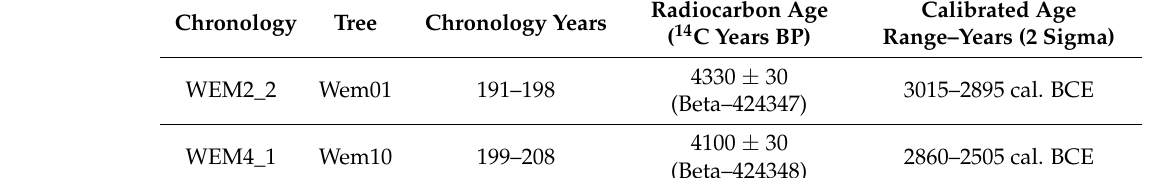
Table 3. Radiocarbon dates associated with samples from chronologies Wem2_2 and Wem4_1.